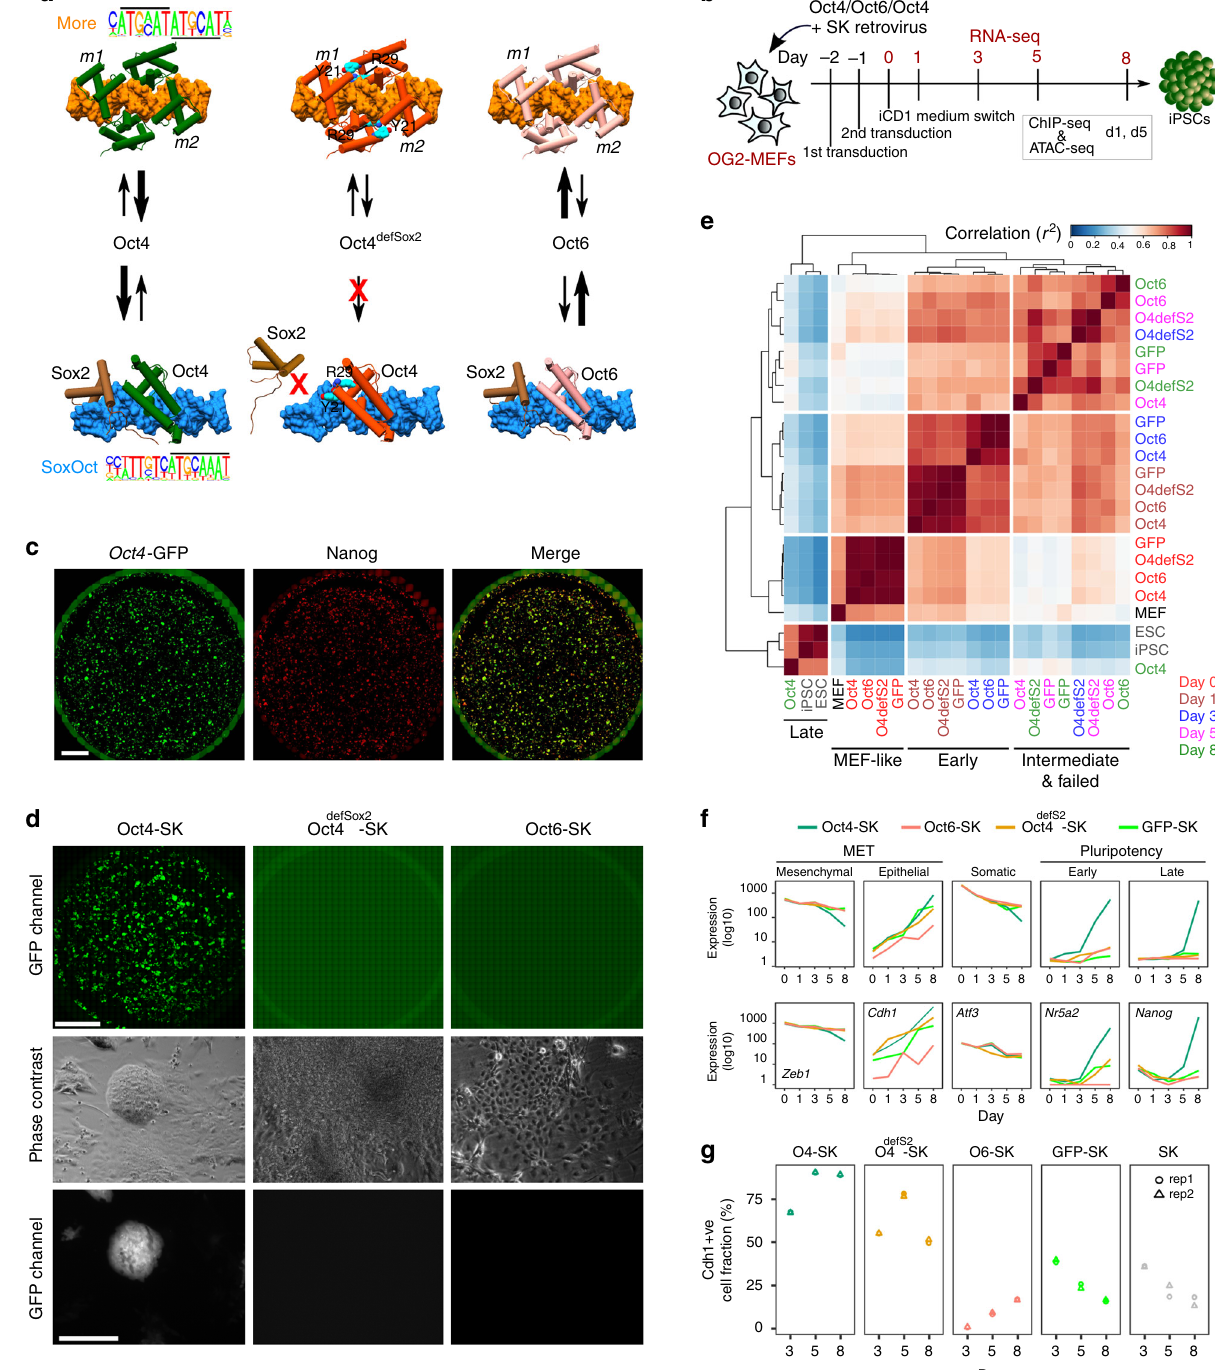
Cis -regulatory dynamics of Oct4 during reprogramming . To link the expression pro fi les to genome occupancy, we performed ChIP-seq (Supplementary Fig. 3A-B, Supplementary Tables 2 – 3) and pro fi led the binding pattern of Oct4 at days 1, 5, and 7. We de fi ned 7 trajectory groups (abbreviated with digits marking presence (1) or absence (0) of binding at days 1, 5, and 7) (Fig. 2a, Supplementary Data 2). De novo motif discovery on each tra- jectory group detected four types of POU motifs: the octamer; the composite SoxOct element; the palindromic MORE anda MORE + 1 variant (Fig. 2b – c). Around 50% of transiently bound sites